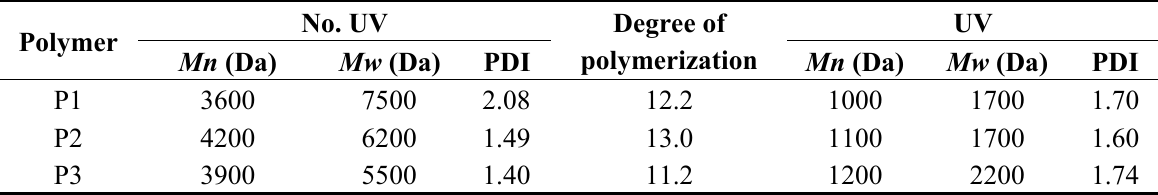
Table 1. GPC data of P1 – 3 before and after 15 min UV irradiation, MW is calculated according to polystyrene